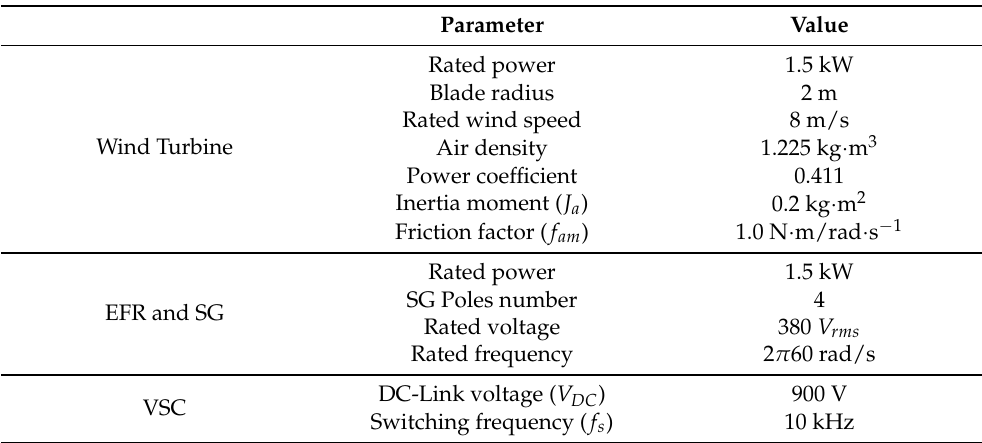
Table 3. EFR-based system’s